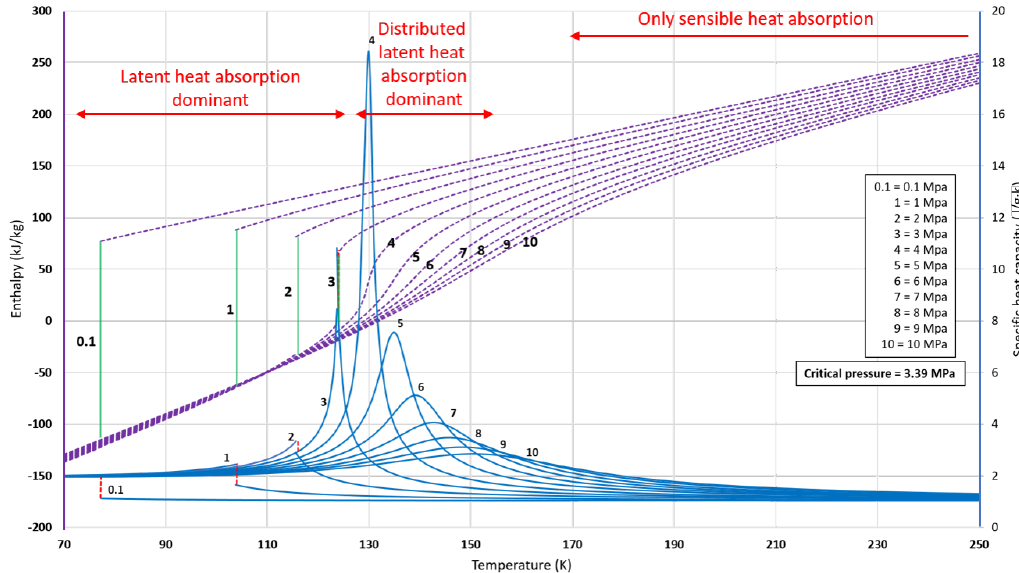
Figure 4. Enthalpy vs. temperature and isobaric heat capacity (C p ) vs. temperature of nitrogen from NIST [17] values for pressures 0.1 to 10 MPa.